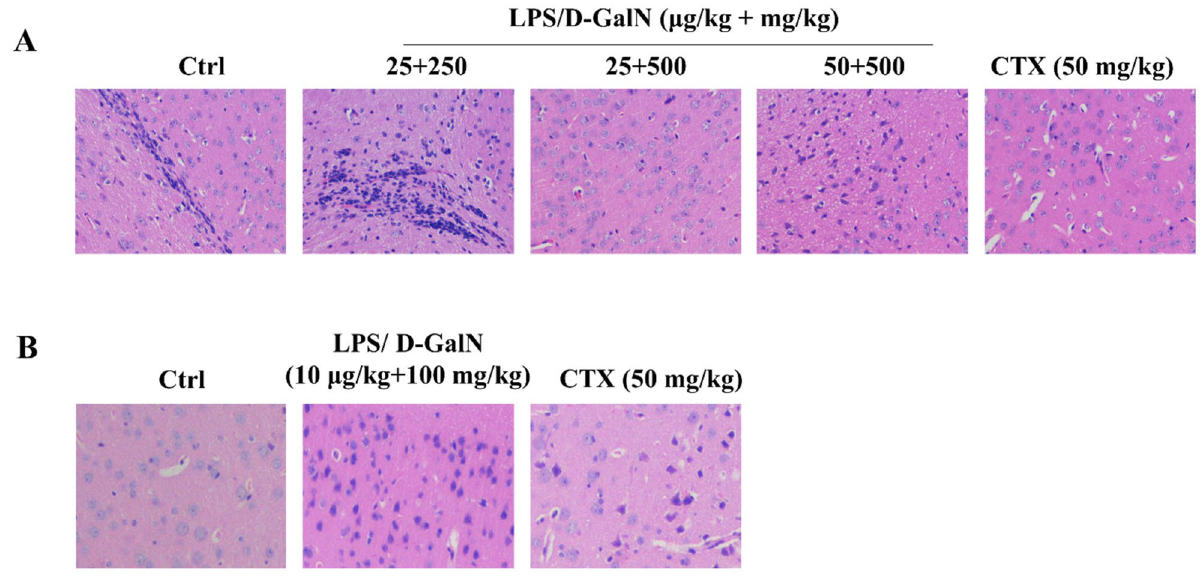
Figure 4. Pathological examination of tissue sections indicating the brain damage. ( A ) Mice were peritoneally injected with LPS/D-GalN (25 μg/kg + 250 mg/kg, 25 μg/kg + 500 mg/kg and 50 μg/kg + 500 mg/kg body weight), 6 h later mice were sacrificed with tissue samples isolated from each mouse. Saline solution (0.9%) and cyclophosphamide (CTX) (50 mg/kg body weight) were used as negative and positive control, respectively. ( B ) Mice were injected with LPS/D-GalN (10 μg/kg + 100 mg/kg body weight), every other day for 8 weeks. Saline solution (0.9%) and cyclophosphamide (CTX) (50 mg/kg body weight) given in the same conditions as above were used as negative and positive control, respectively. Original magnification: